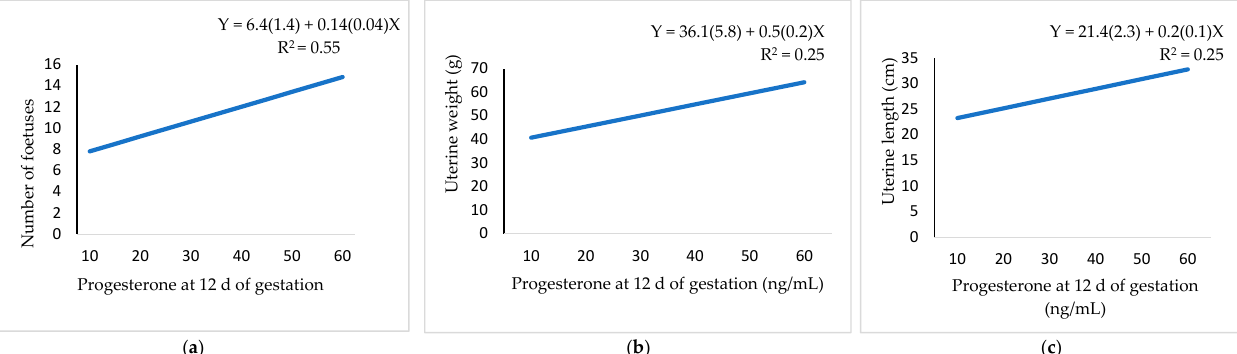
Figure 3. Regression equation (standard error between brackets) at 12 d of gestation for the relationship between: ( a ) perirenal fat thickness and total foetal weight; ( b ) leptin and total foetal weight; ( c ) progesterone and total foetal placenta weight; ( d ) progesterone and total maternal placenta weight.